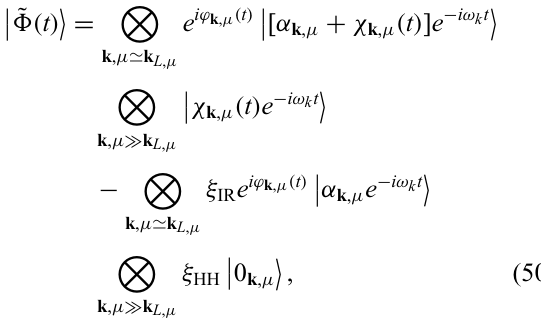
FIG. 4. High-harmonic generation spectrum obtained from the evaluation of Eq. (48) using the QPROP software [119], when a hydrogen atom in the ground state ( I p = 0.5 a.u.) interacts with a linearly polarized electromagnetic field with a sinusoidal squared envelope that has ten cycles, driving frequency ω = 0.057 a.u., and electric field amplitude E = 0.053 a.u. The harmonic yield extends until the 21st harmonic, which constitutes the cutoff fre- quency of the spectrum, that is, the maximum energy that can be gained by the electron when accelerating in the